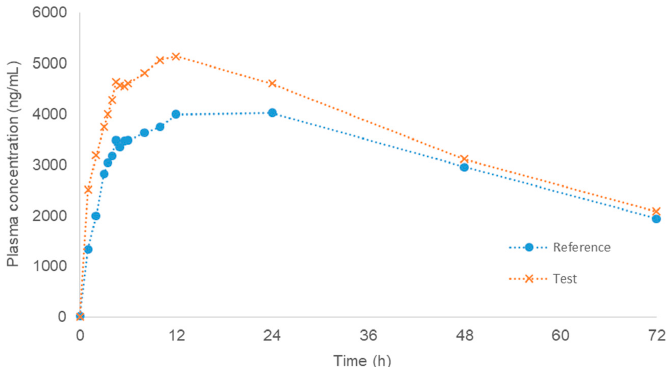
Figure 2. Reference and test average plasma levels ( N = 11, pilot bioequivalence study).